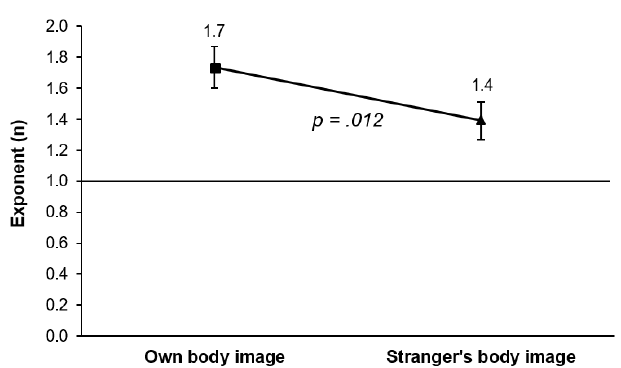
Figure 5. Geometric mean of the power function’s exponents in two psychophysical magnitude estimation tasks, with distorted body imag- es of own body and a stranger’s body of a group of female adolescents at risk for body image disorders (Paula, 2010). (Standard errors in